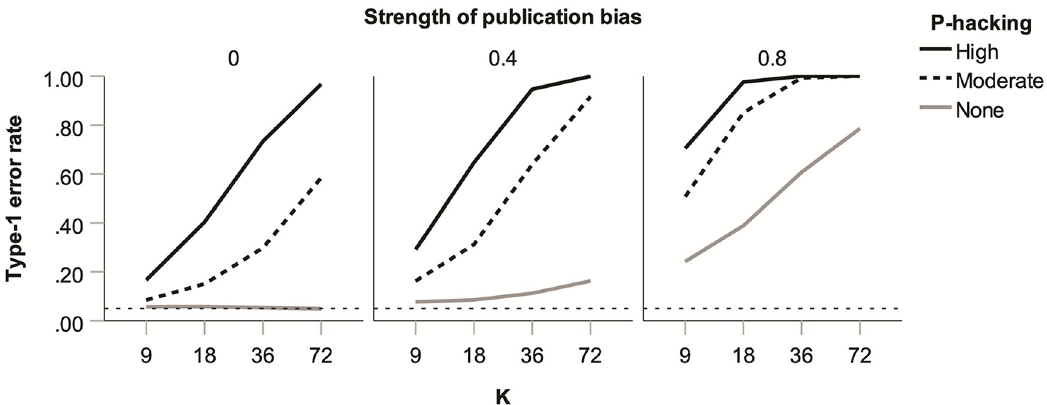
Fig 9. Type-1 error rates for d under 1-tailed publication bias as a function of strength of publication bias, level of p -hacking, and number of studies in the meta-analysis ( k ). Data shown are for conditions with θ = 0 and are based on the DL estimator but are very similar for other